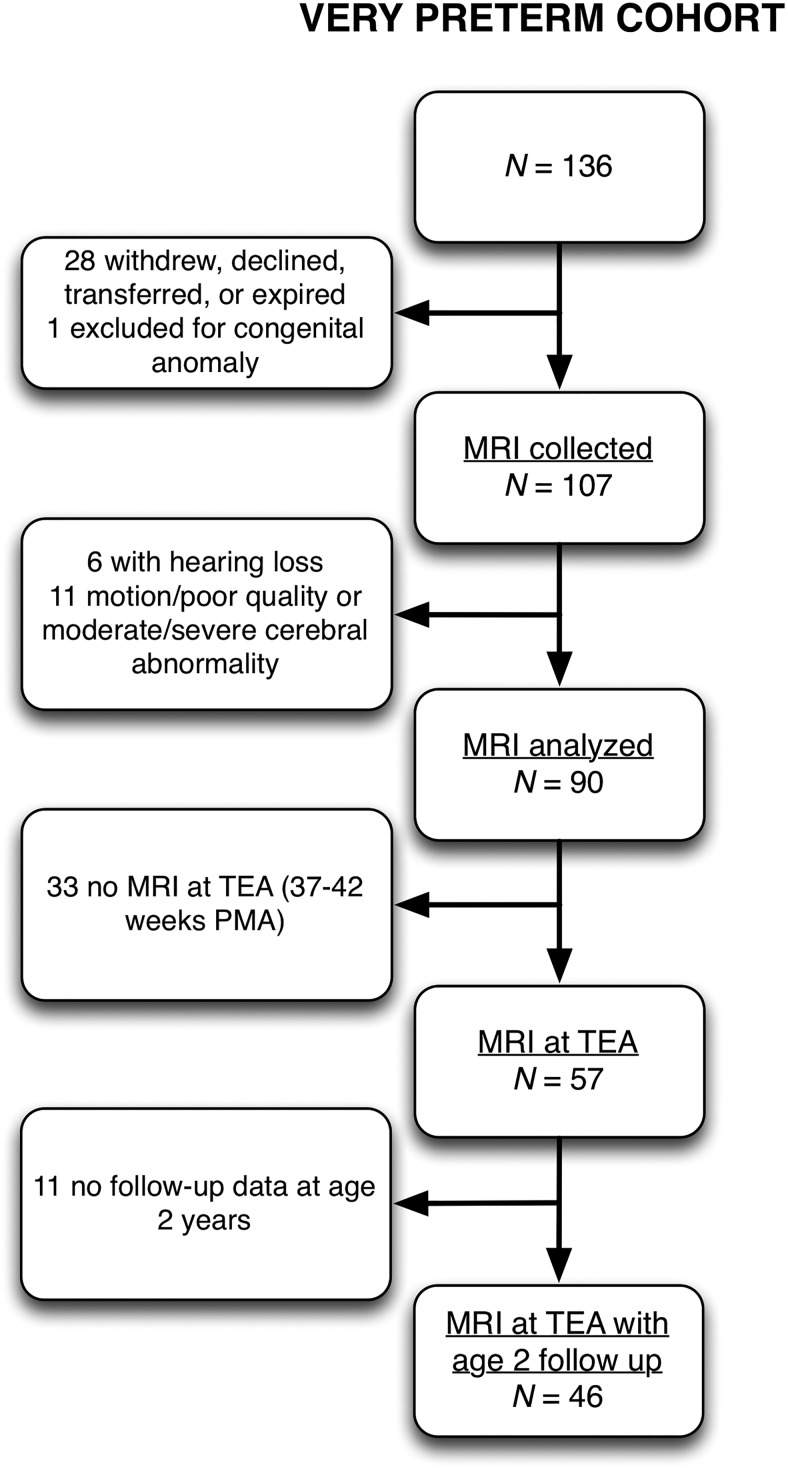
Flowchart detailing retention and follow-up of the very preterm cohort. TEA, term-equivalent age.